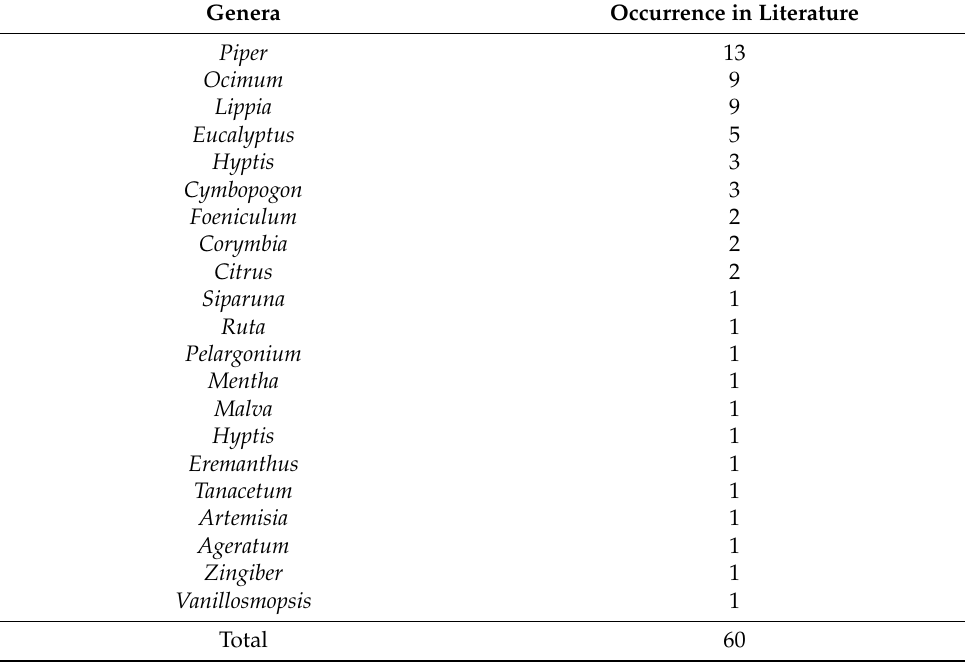
Table 2. Plant genera whose essential oils have been evaluated as insecticides against Spodoptera frugiperda